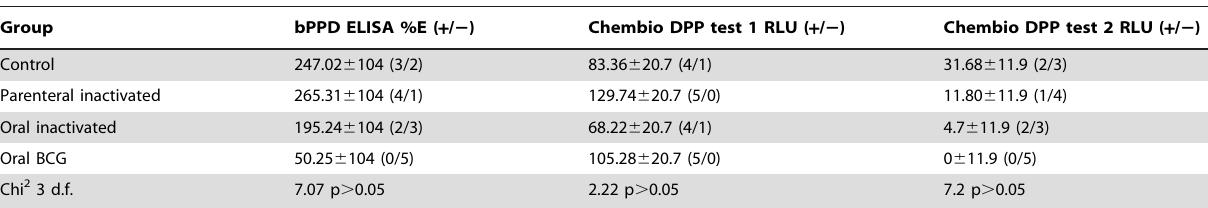
Table 3. Serum antibody levels at necropsy for 20 wild boar belonging to four experimental groups (mean 6 SE), as measured by the bPPD ELISA (in ELISA percentage, E%) and the dual-path platform tests (DPP, in relative light units, RLU; DPP test 1: MPB83; DPP test 2: